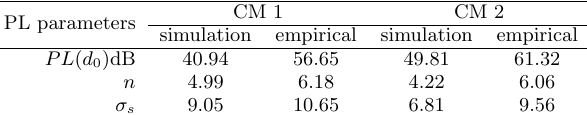
Table 6: Comparision of our empirical results and simulation results from